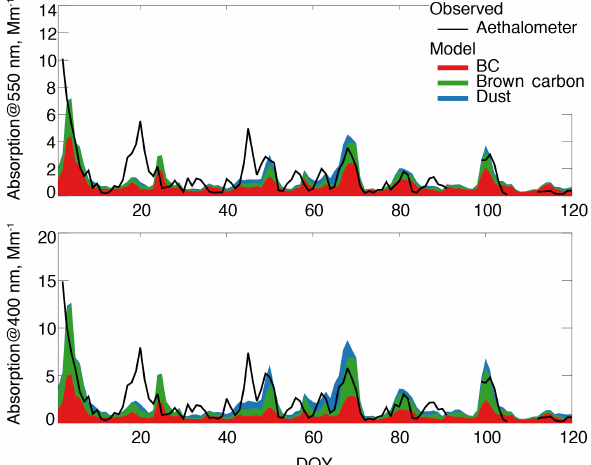
Figure 12. Time series of Aethalometer and model absorption at 550nm (top) and 400nm (bottom) at ATTO during January–April 2014. The model results are further separated into BC, brown car- bon, and dust.